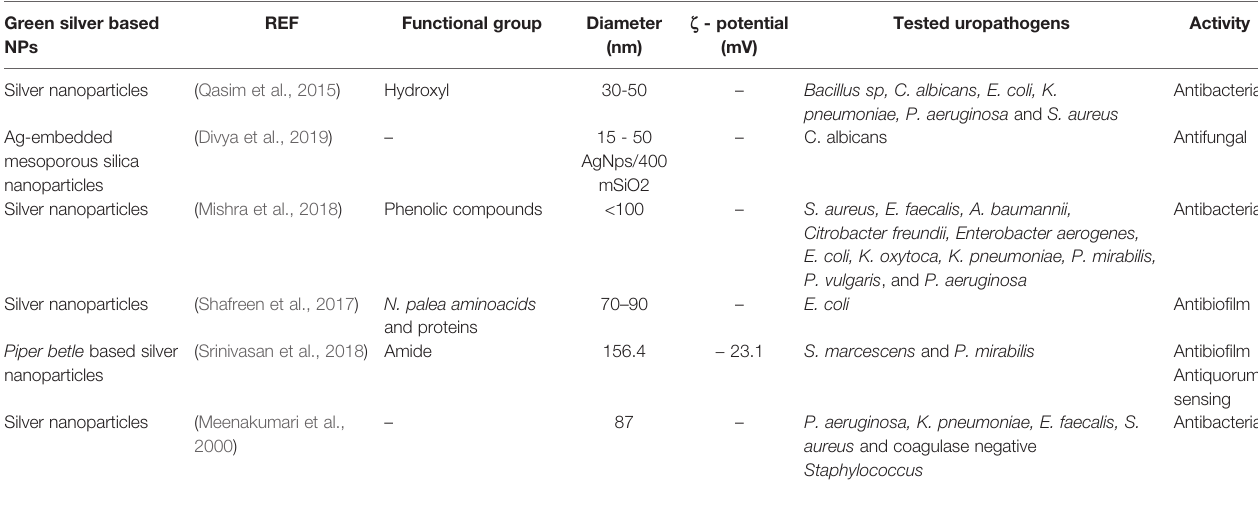
TABLE 4 | Physicochemical properties of green silver-based